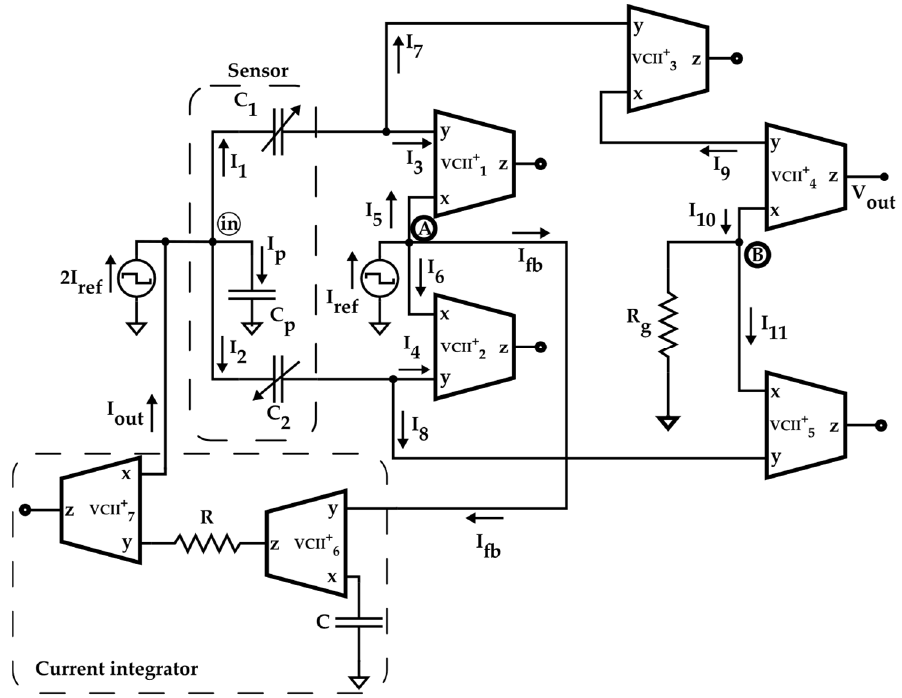
Figure 11. VCII-based readout circuit for differential capacitive sensors [24].